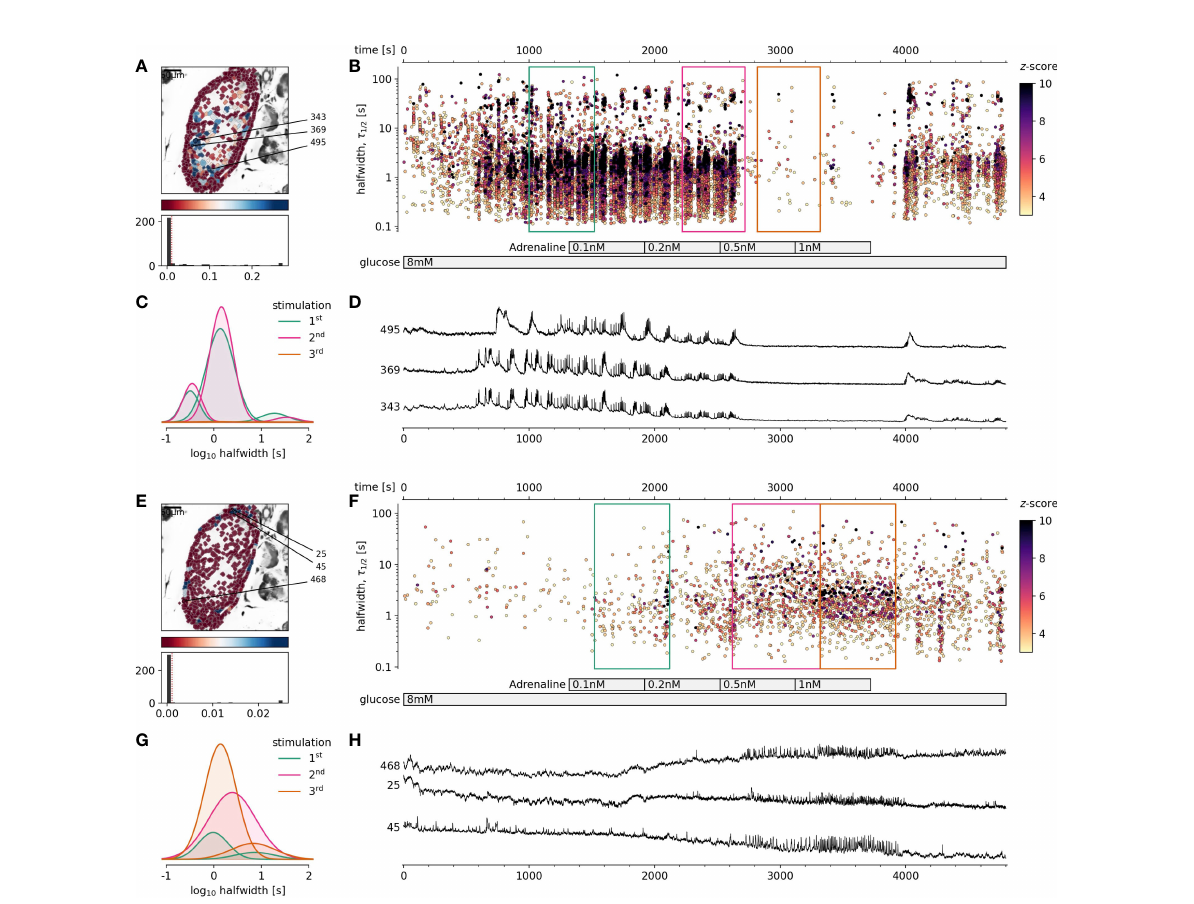
FIGURE 1 The effect of physiological adrenaline on beta and alpha cells activity at 8 mM glucose. (A-D) Beta cells, (E-H) Alpha cells. (A, E) , Regions of interest (ROIs) obtained by our segmentation algorithm. The color indicates the number of events identi fi ed in the ROI trace, upon a high-pass fi ltering at 0.2Hz. We discarded ROIs with number of events below the threshold (red dashed line in the histogram in the lower panel). Indicated are the ROI numbers whose fi ltered traces correlate best with the average trace for the whole islet. (B, F) , Events ’ halfwidth duration through time. Note the ranges of halfwidth duration occurring, the events ’ synchronicity, and a concentration-dependent block of the activity in beta cells, as well as activation in alpha cells with increasing adrenaline concentration. Color indicates the statistical signi fi cance in terms of z -score as indicated. The treatment protocol is indicated in the bar at the bottom of the pane. Due to a signi fi cantly larger number of ROIs corresponding to beta cells in comparison to alpha cells, this representation should not be used to compare the activity of both cell types directly. (C, G) , Normalized Gaussian fi ts through the logarithmic distribution of halfwidth duration, indicated temporal summation producing 3 discrete modes in beta cells and mostly 1 mode in alpha cells. (D, H) , Time courses from ROIs indicated in A and E, exposed to an increasing concentration of adrenaline, and rebinned to 2 Hz (recorded at 20